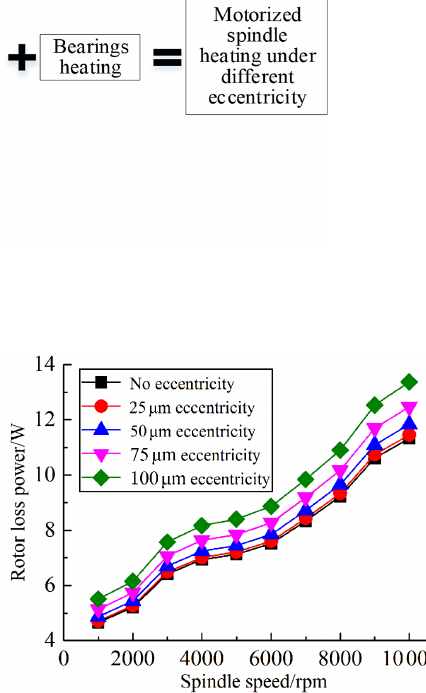
Figure 5. The electrical loss of the rotor with different eccentrici- ties.